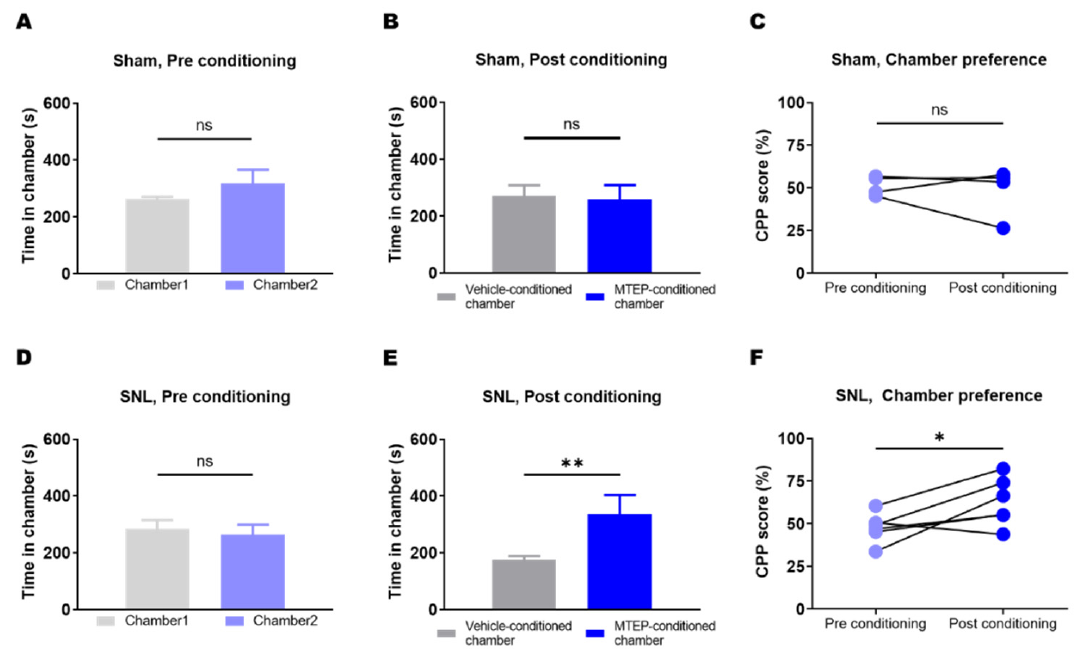
Figure 4. Microinjection of the mGluR5 antagonist into the S1DZ ameliorated SNL-induced spon- taneous ongoing pain. ( A ) Baseline chamber preference was absent in the sham group (ns: not signif- icant; two-sample t -test; n = 4). ( B ) Even after conditioning, time spent in each chamber was not different in the sham group (ns: not significant; two-sample t -test; n = 4). ( C ) The preference for the chamber did not change before and after the MTEP conditioning in the sham group (ns: not signif- icant; paired t -test; n = 4). ( D ) Baseline chamber preference was absent in the SNL group (ns: not significant; two-sample t -test; n = 6). ( E ) After the conditioning, the SNL group spent more time in the MTEP-conditioned chamber than in the vehicle-conditioned chamber (** p < 0.01; two-sample t - test; n = 6). ( F ) The SNL group developed a preference for a chamber conditioned with MTEP mi- croinjection into the S1DZ (* p < 0.05; paired t -test; n = 6).